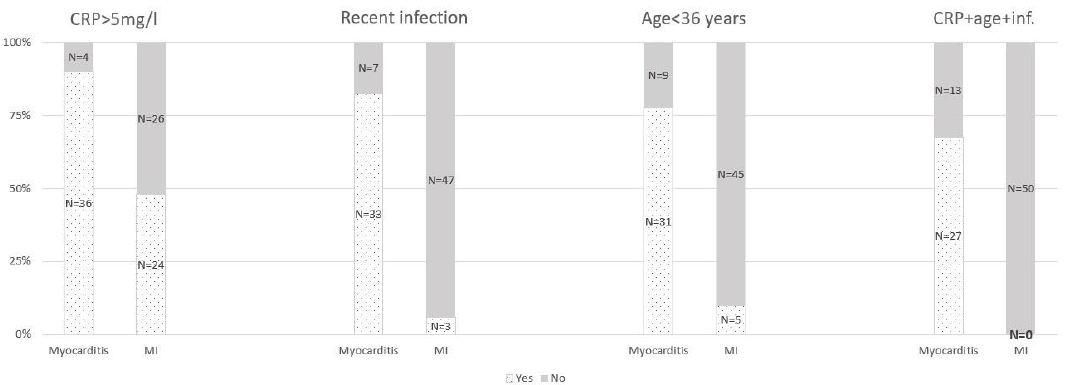
Figure 5. Multiparametric model including abnormal CRP level on admission > 5 mg/L, history of recent infection, and age <36 years; all three are divided into groups presented as number of patients (%).